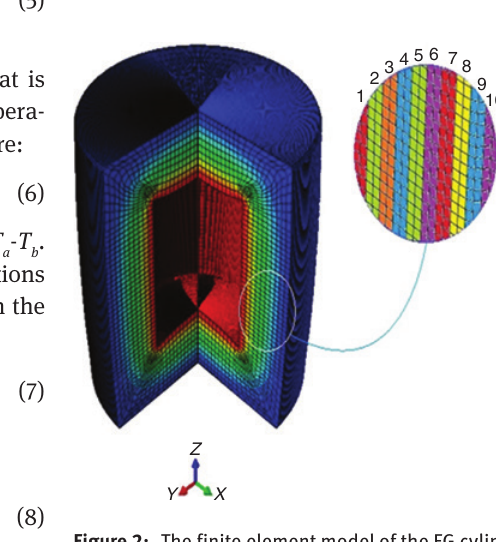
Figure 2: The finite element model of the FG